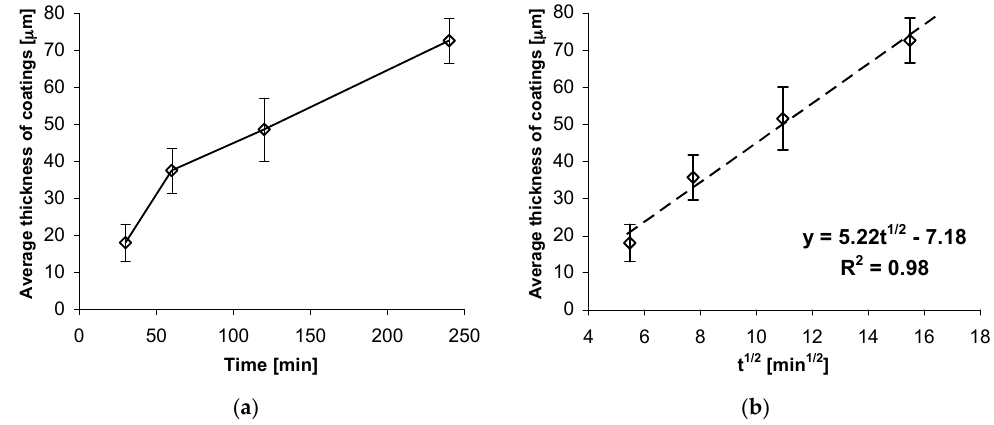
Figure 2. Growth kinetics ( a ) and plot of coating thickness as a function of t 1/2 ( b ).